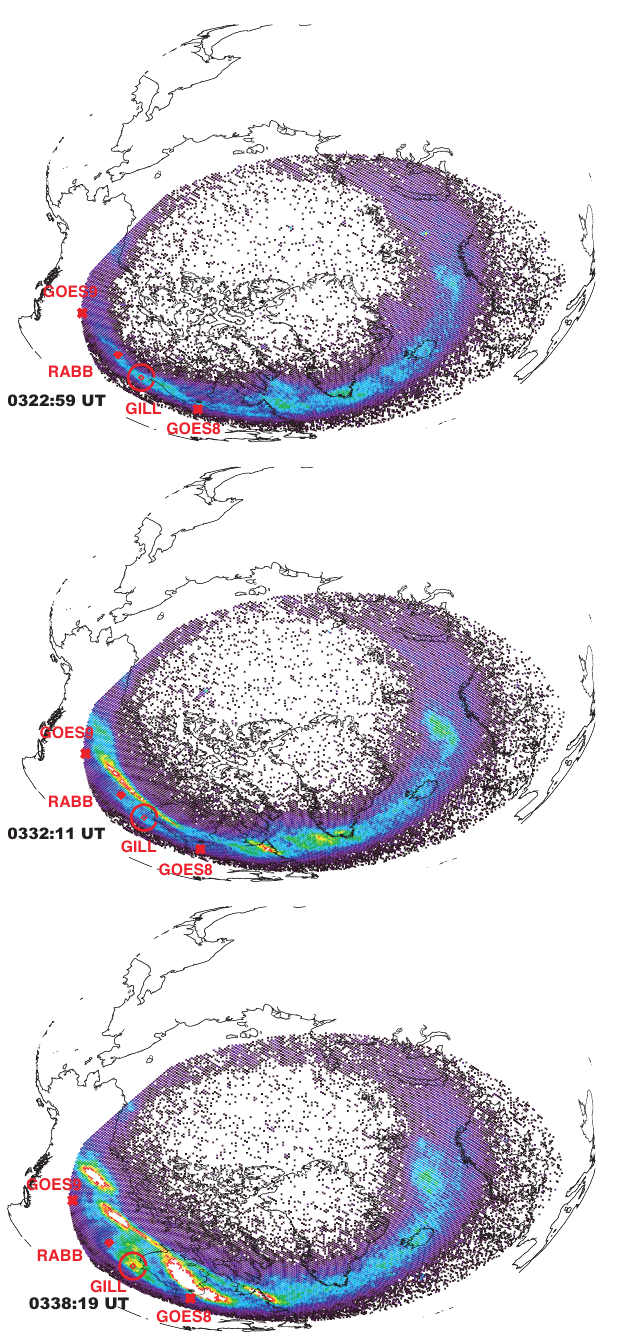
Fig. 2. Three Polar UVI (LBHL) images taken at 03:22:59 UT, 03:32:11 UT and 03:38:19 UT show the auroral bulge with the most intense precipitation at the poleward edge and only faint arcs inside. Red asterisks mark the footpoint of the GOES 8 and 9 satellites, and the ground magnetometer and riometer station at Rabbit Lake (RABB). The red circle shows an estimate of the ASI FoV at Gillam (GILL). Magnetic local midnight is down in the figure.